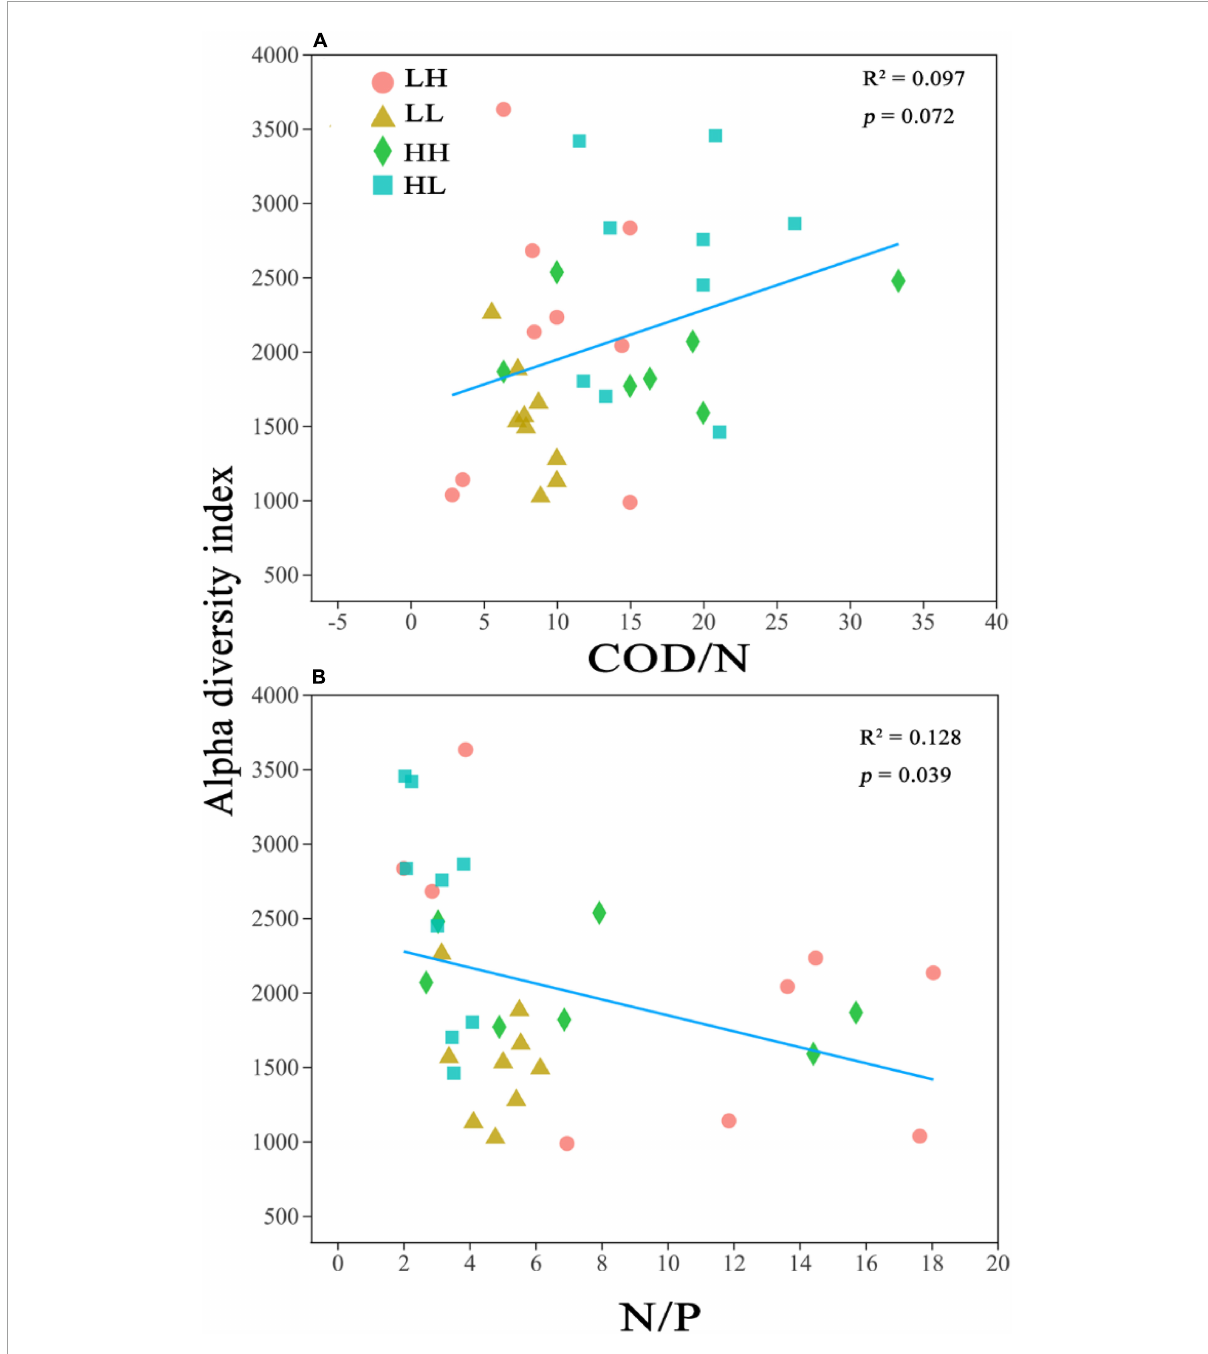
FIGURE2 Relationship between bacterial alpha diversity (Chao1) and (A) Chemical oxygen demand to nitrogen (COD/N) and (B) nitrogen to phosphorus (N/P). R 2 represents the correlation coefficient, p < 0.05 indicates significance and p > 0.05 indicates non-significance.